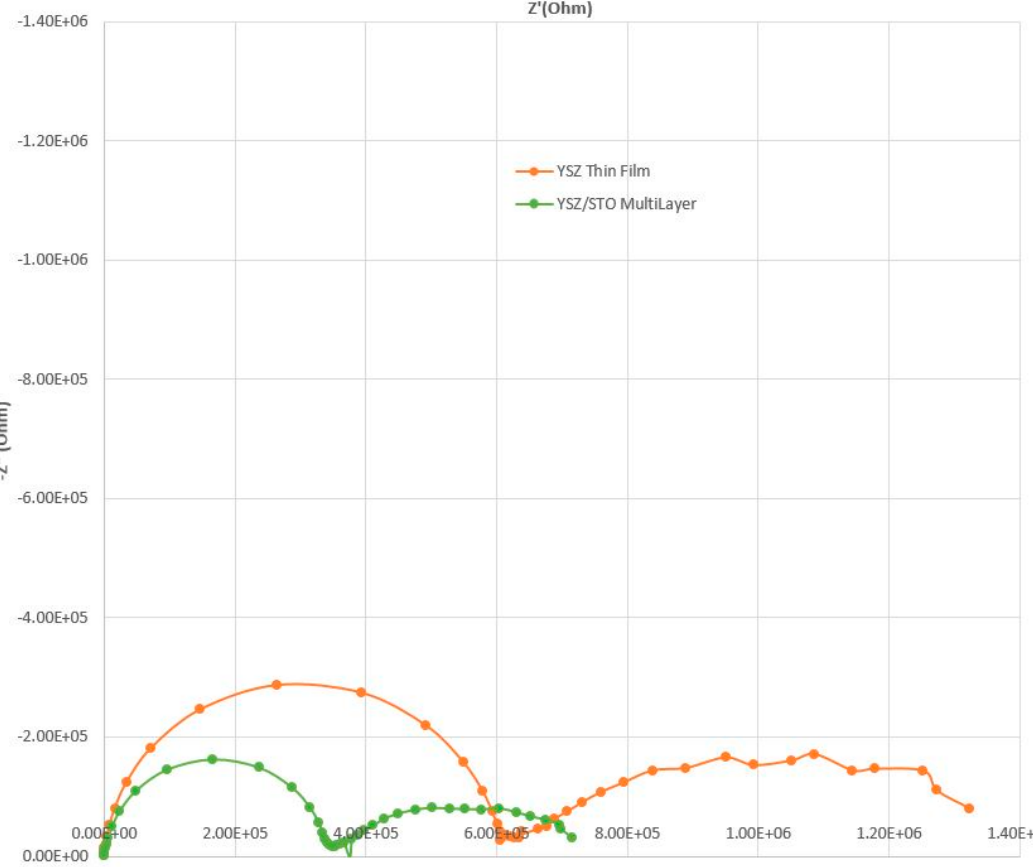
Figure 3. Comparison of impedance spectra obtained from two devices made of YSZ/STO multilayer thin-film electrolyte and plain YSZ thin film at 200 °C, 21% O 2 , and 25 ppm of C 3 H 6 .